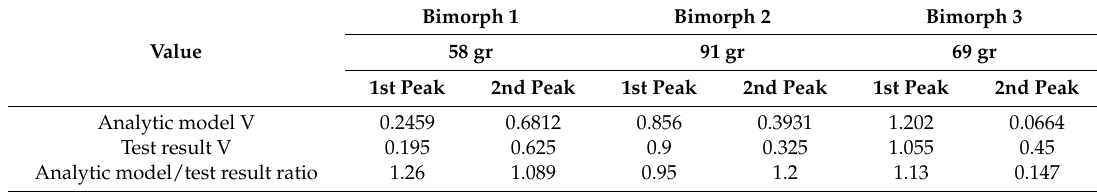
Table 5. Experimental results vs. analytical predictions (series electrical connection)—the three bimorphs system.